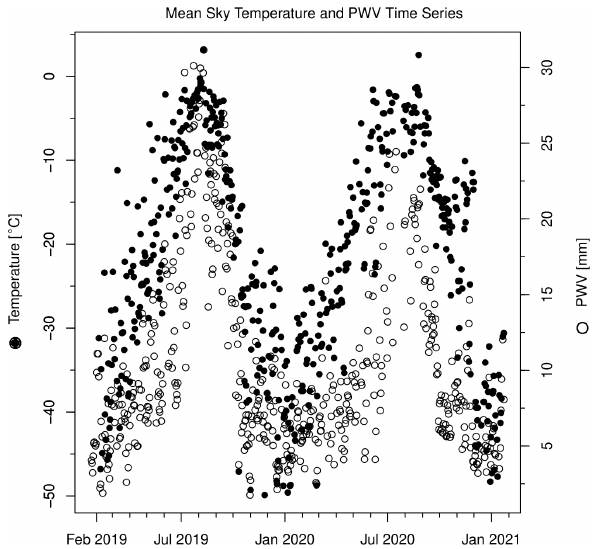
Figure 4. Time series composite of sky temperature (black) and pre- cipitable water (white) over the period from January 2019 through January